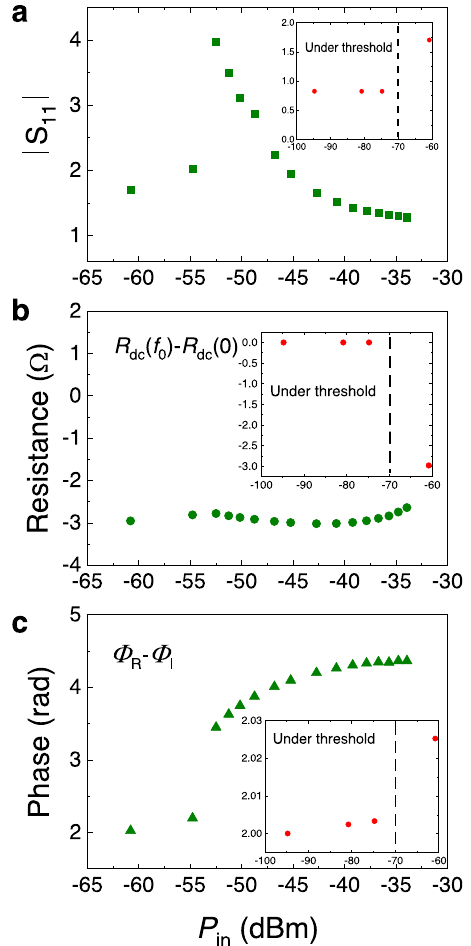
Fig. 5 | Micromagnetic simulations. a |S 11 |calculated from the micromagnetic simulations by using Eq. (2) as a function of the input power in dBm. b and (cid:5) (cid:6) (cid:2) R ð 0 Þ and Φ (cid:2) Φ c Micromagnetic calculations of R dc f 0 dc R I as a function of the input power P in in dBm, the R dc is the dc resistance, Φ R − Φ I is the phase shift. The insetsofeachpanelshowthecalculationsfrom – 60to − 100dBm.Thecalculations havebeenperformedforacurrent J dc = − 1.5×10 5 A/cm 2 .Forthiscurrentdensitythe self-oscillationexcitationissub-criticalindeterministicsimulations.Intheinsetwe have also indicated the power at which the self-oscillation is not excited. The inset of each panel displays the data for the power range between − 60 and − 100dBm.